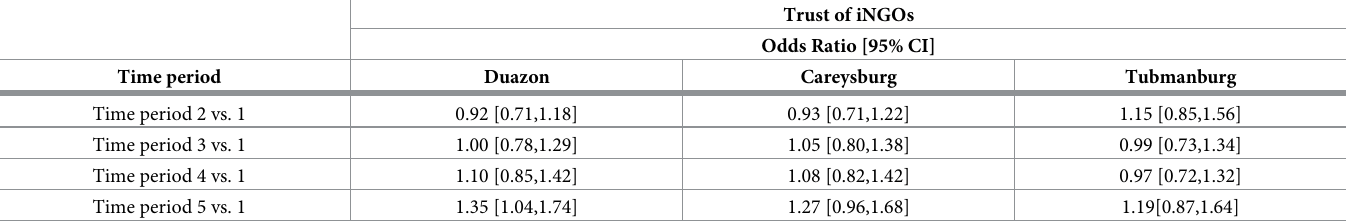
Table 5. Odds ratios and 95% confidence intervals for trust in Time Periods 2–5 vs. in Time Period 1 for trust of iNGOs in Duazon (peri-urban, high exposure), Car- eysburg (rural, low exposure), and Tubmanburg (urban, high incidence). Odds ratios were calculated from an ordinal logistic regression model. In the first